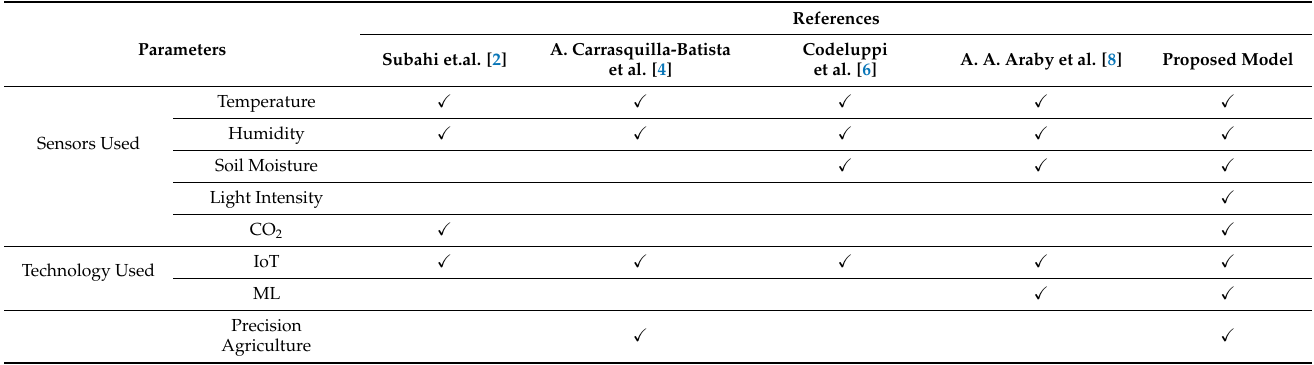
Table 1. Comparative analysis table.